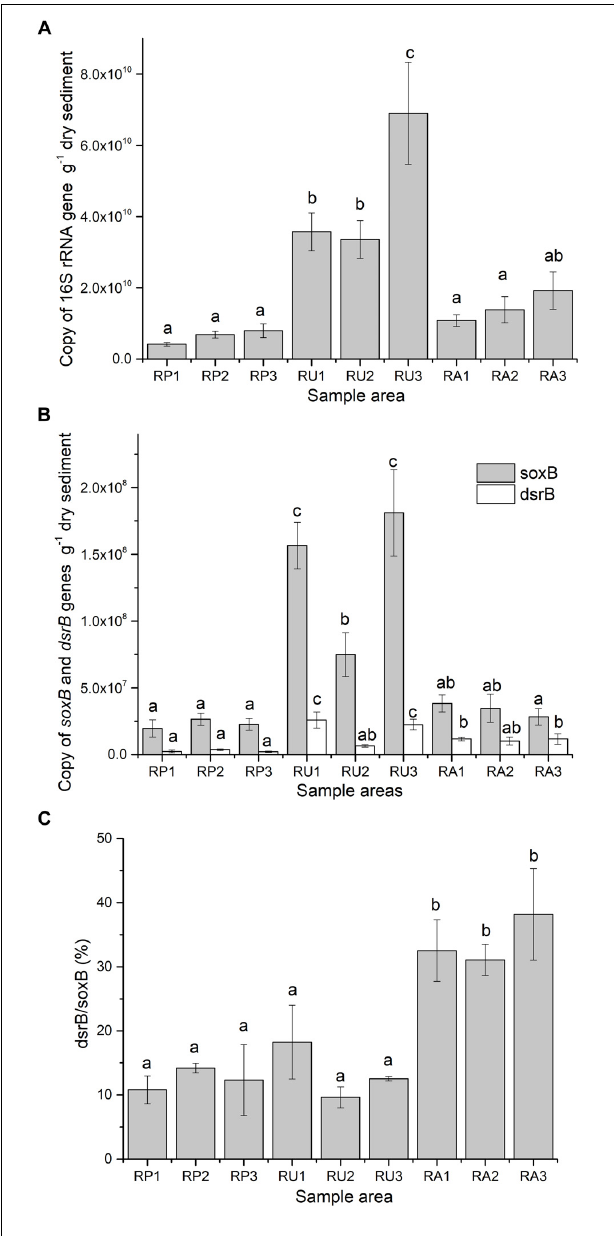
FIGURE 1 | Abundance of 16S rRNA (A) , aprA, and dsrB gene copies (B) and the ratio of dsrB to soxB (C) in odorous river sediments with different types of human intervention. Values are represented by average values from three replications with standard errors. Different letters indicate a significant difference ( P < 0.05). RP, protected wildlife reserve region; RU, region polluted by human urban activity; RA, region polluted by human agricultural activity.